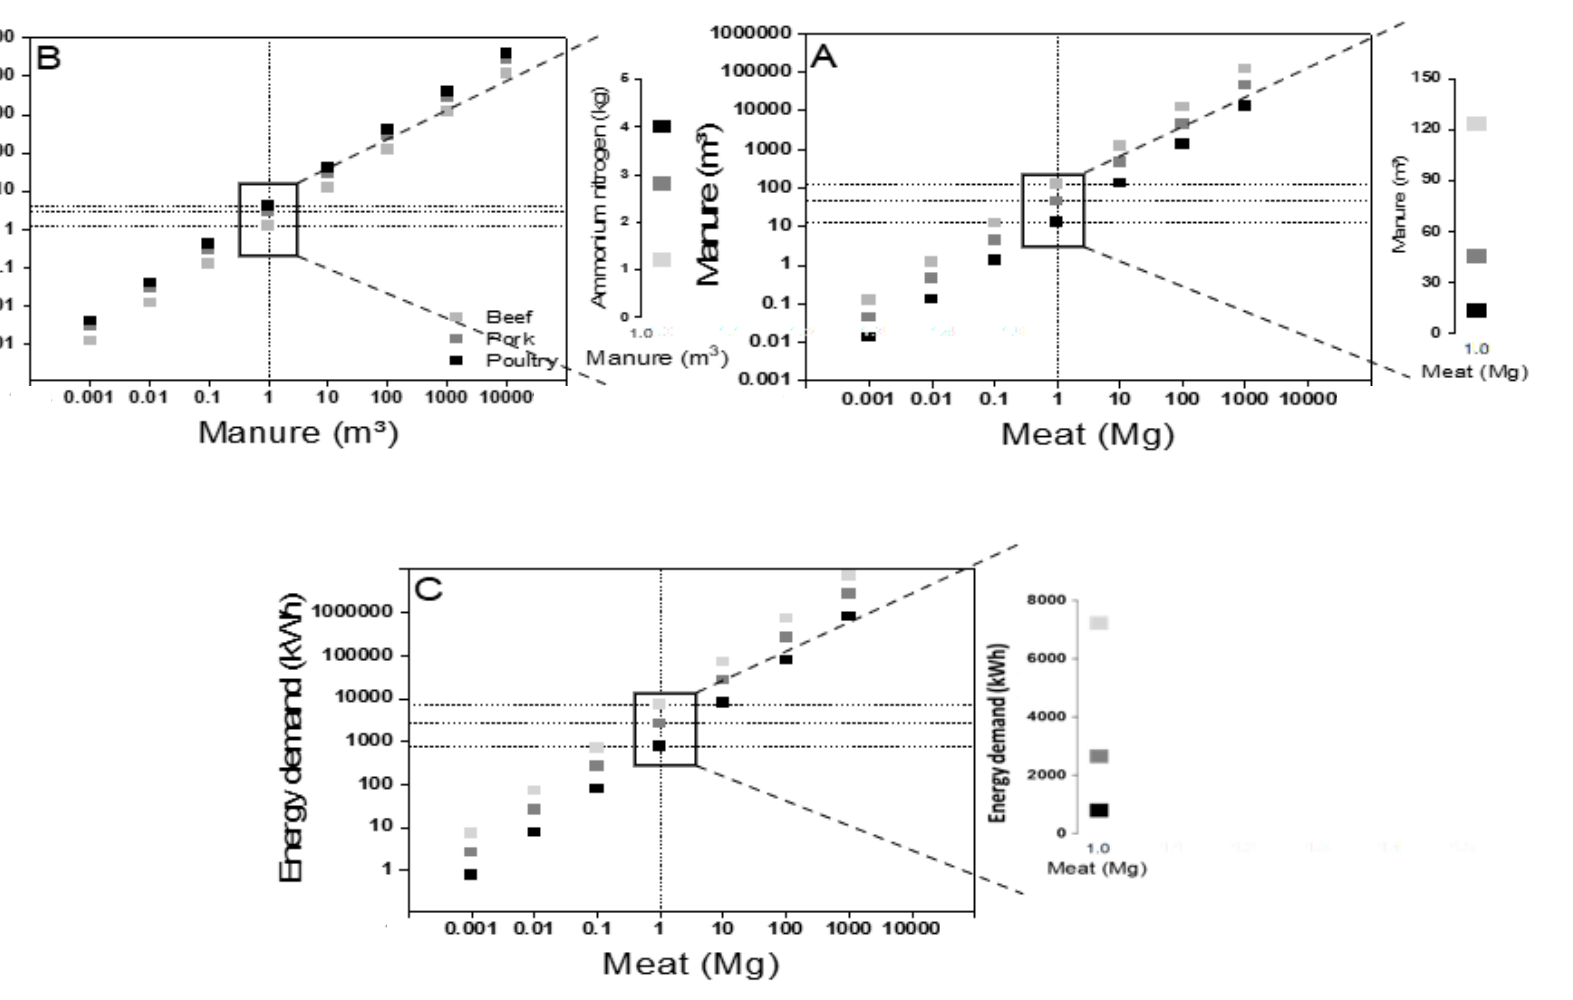
Figure 4. ( A ) The relationship between meat production and manure generation, ( B ) ammonium nitrogen recovery by treating per unit m 3 of manure and ( C ) the corresponding energy demand to treat manure per Mg of beef, pork and poultry meat production.